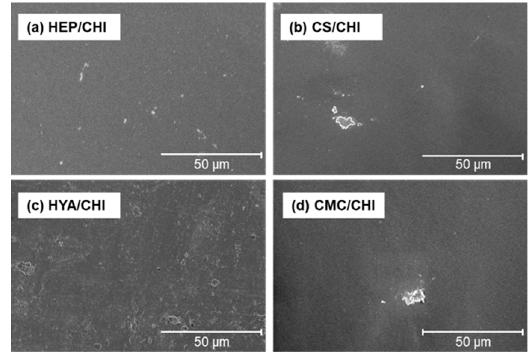
Figure 3. Scanning electron microscopic (SEM) images of polysaccharide composite films composed of HEP/CHI ( a ), CS/CHI ( b ), HYA/CHI ( c ), and CMC/CHI ( d ).